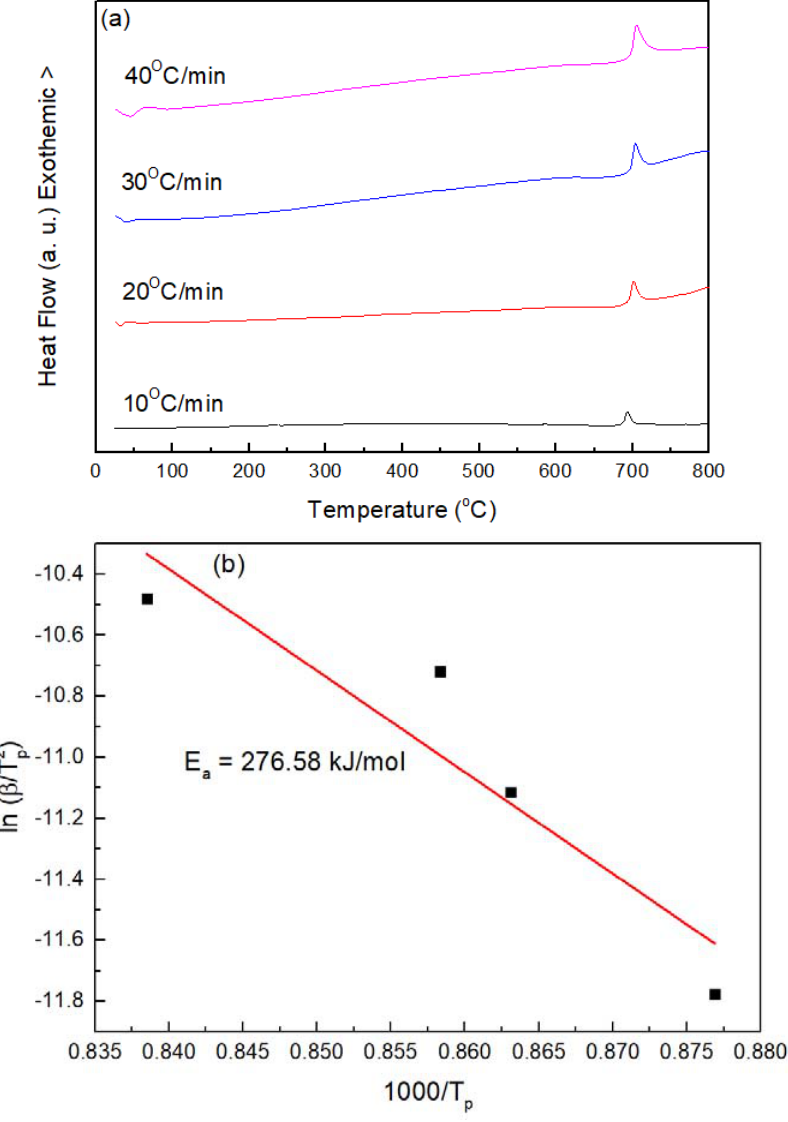
Figure 5. ( a ) DSC curves of Fe-based amorphous alloy coatings using heating rates of 10, 20, 30, and 40 °C/min. ( b ) Kissinger plot for the recrystallization exothermic peaks of Fe-based amorphous alloy coatings.